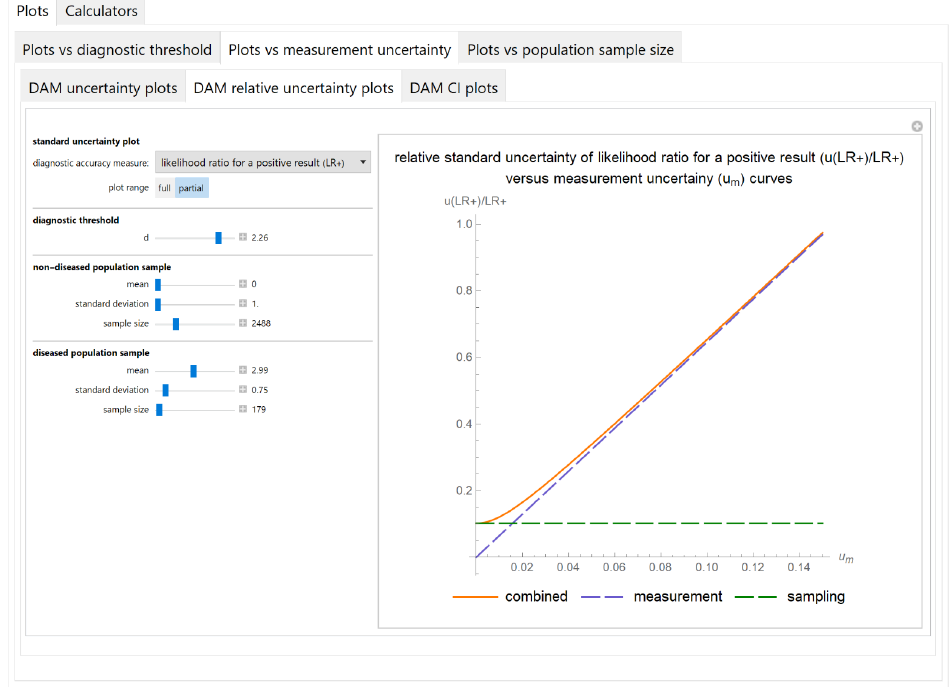
Figure 7. Plots vs. measurement uncertainty module, DAM relative uncertainty plots submodule screenshot. Relative standard combined, measurement and sampling uncertainty of likelihood ratio for a positive test result ( u(LR +)/LR+ ) vs. measurement uncertainty ( u m ) curves plot, with the settings shown on the left. The respective parameter settings are also shown in Table 3. Confidence Intervals of Diagnostic Accuracy Measures Plots Submodule The values of the lower and upper bounds of the confidence intervals of diagnostic accuracy measures of a screening or diagnostic test, at a selected confidence level, are plotted versus the measurement uncertainty of the test (Figure 8).